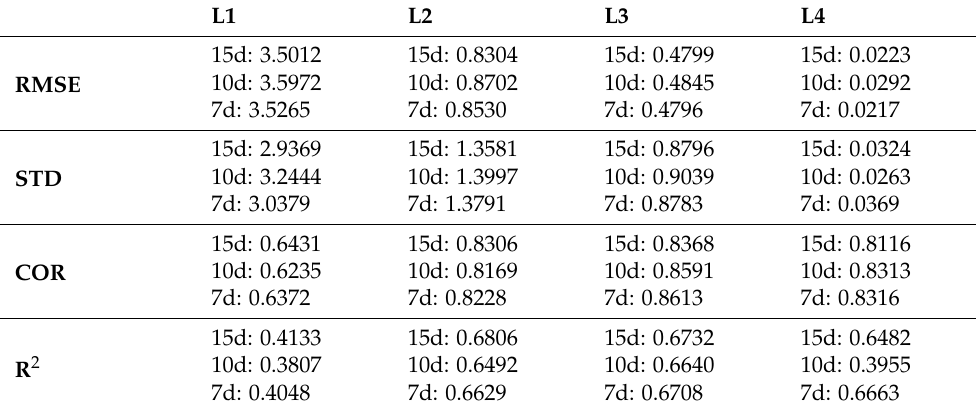
Table 3. Values of RMSE , STD , COR, and R 2 at four points for different input lengths. Here, 15d indicates the results using data of the first 15 days to predict, 10d indicates the results using data of the first 10 days, and 7d indicates the results using data of the first seven